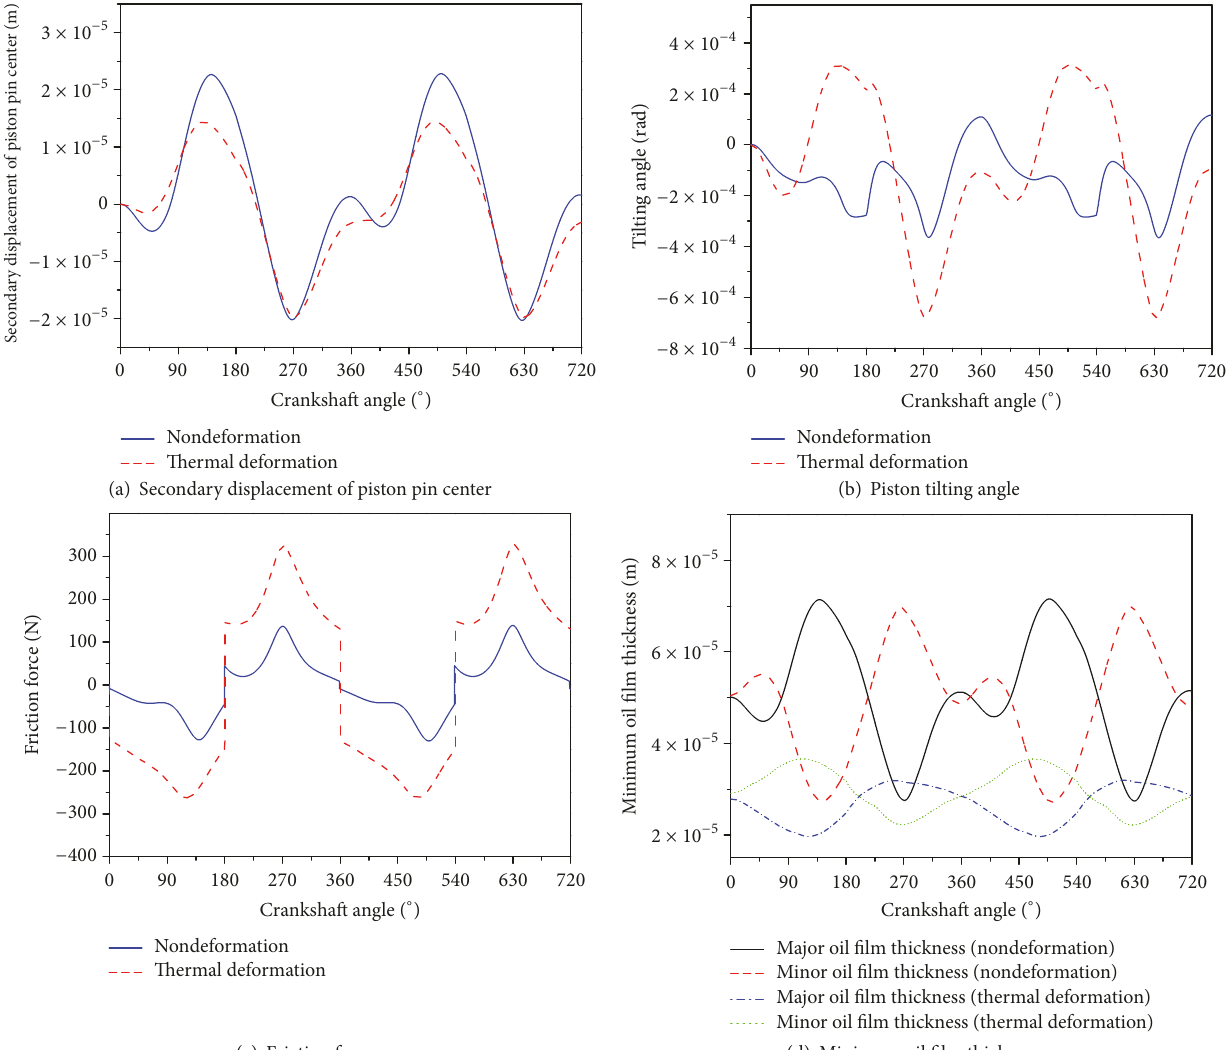
Figure 21: Profiles of piston skirt and cylinder liner before and after thermal